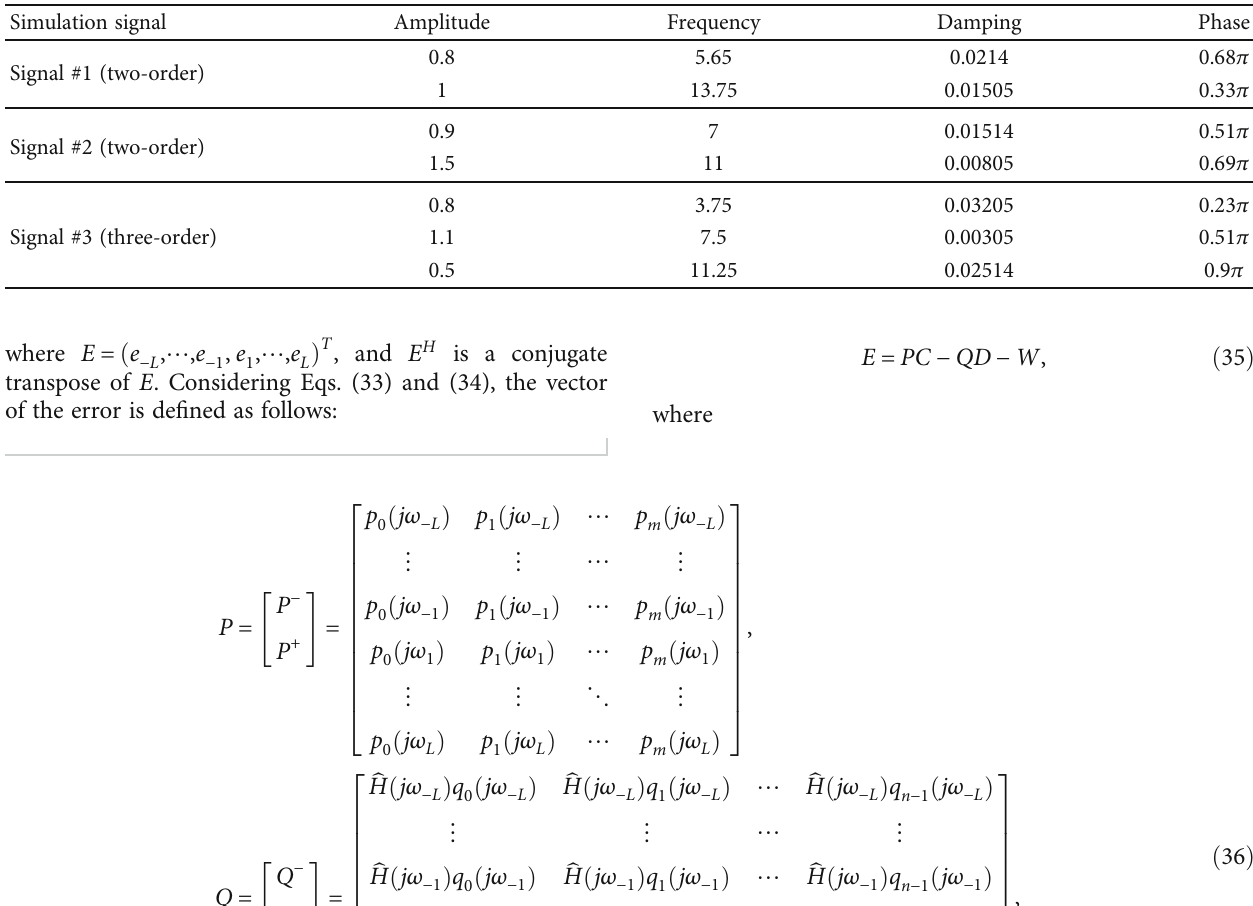
Table 1: Parameters of the simulation